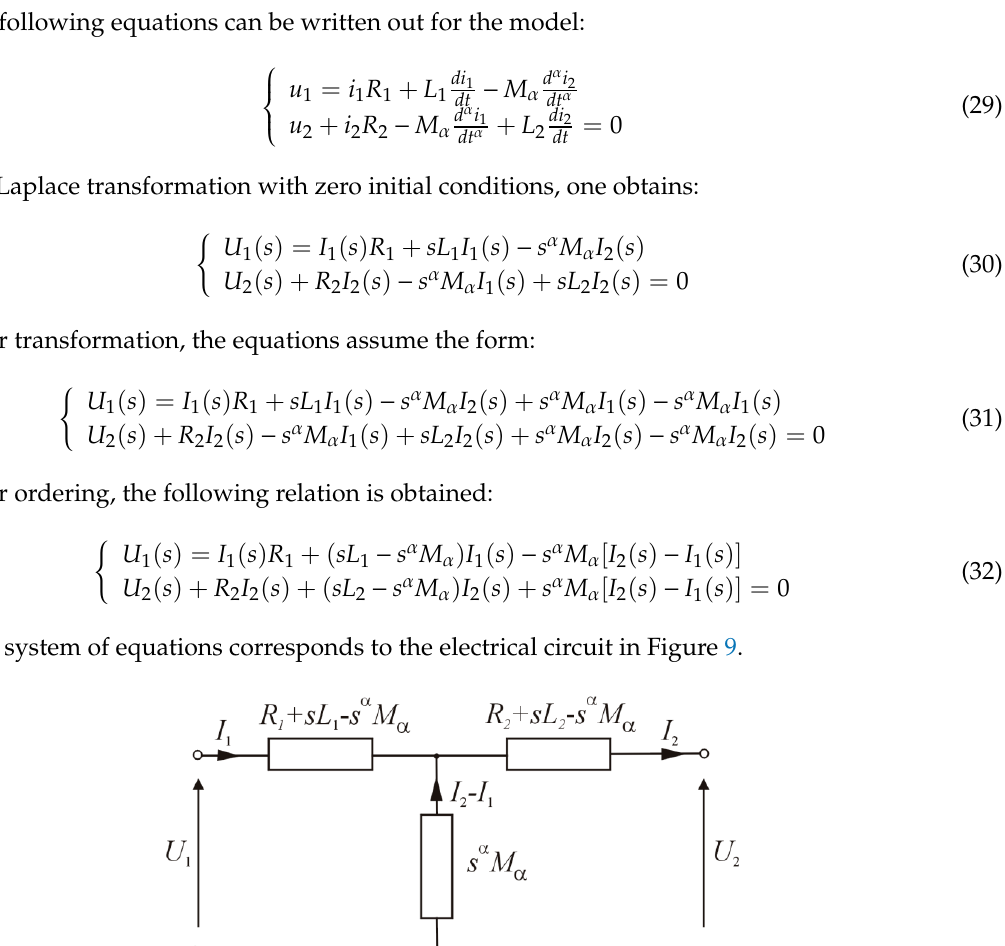
Figure 9. Circuit with magnetic coupling eliminated.